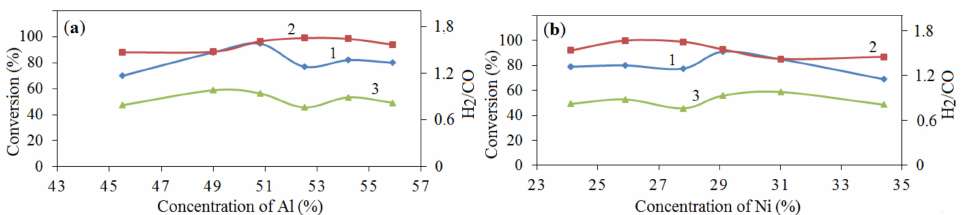
Figure 14. Effect of the content of Al and Ni in the composition of the catalyst on the conversion of CH 4 and CO 2 , as well as the H 2 /CO ratio: ( a ) Al, ( b ) Ni. Note: 1—CH 4 conversion, 2—CO 2 conversion, 3—H 2 /CO ratio. T = 900 ◦ C.